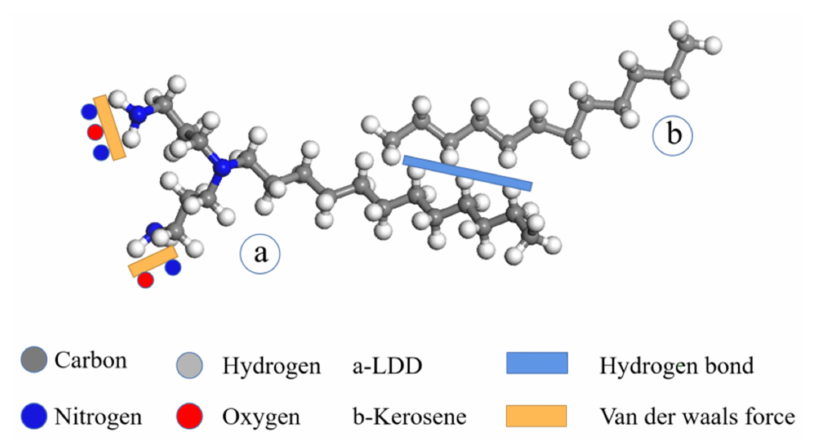
Figure 3. The adsorption between LDD and kerosene (a diagram of molecular